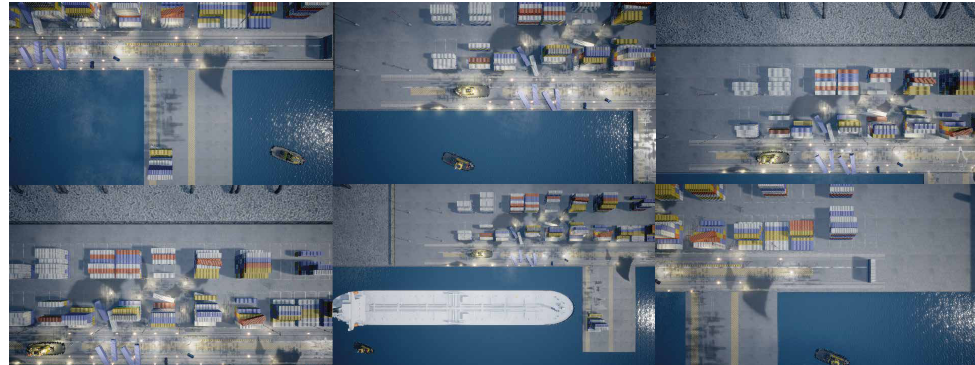
Figure 16. Example of new images in dataset version 1.2 .